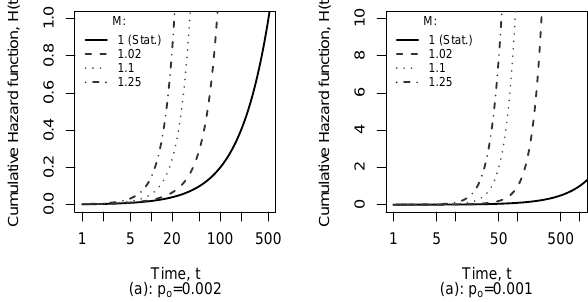
Figure 2. Survival function S T (t) for the nonstationary GP2 model, p o = 0.002 and C x = 0.75, for a range of trend values ( M = 1, 1.02, 1.1, 1.25); lines represent theory (Eq. 13) and points are empirical values from Monte Carlo simulation.